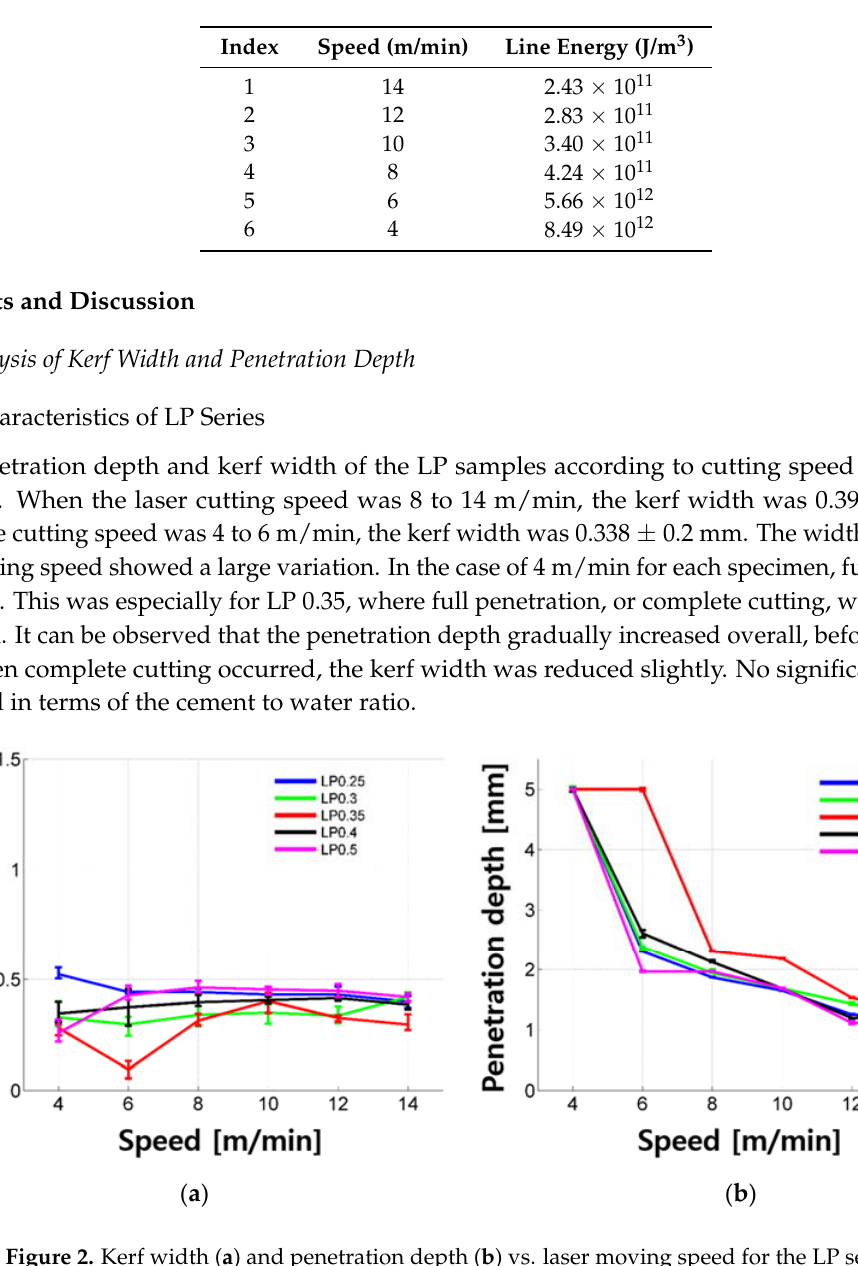
Table 3. Laser parameters used for the experiments.